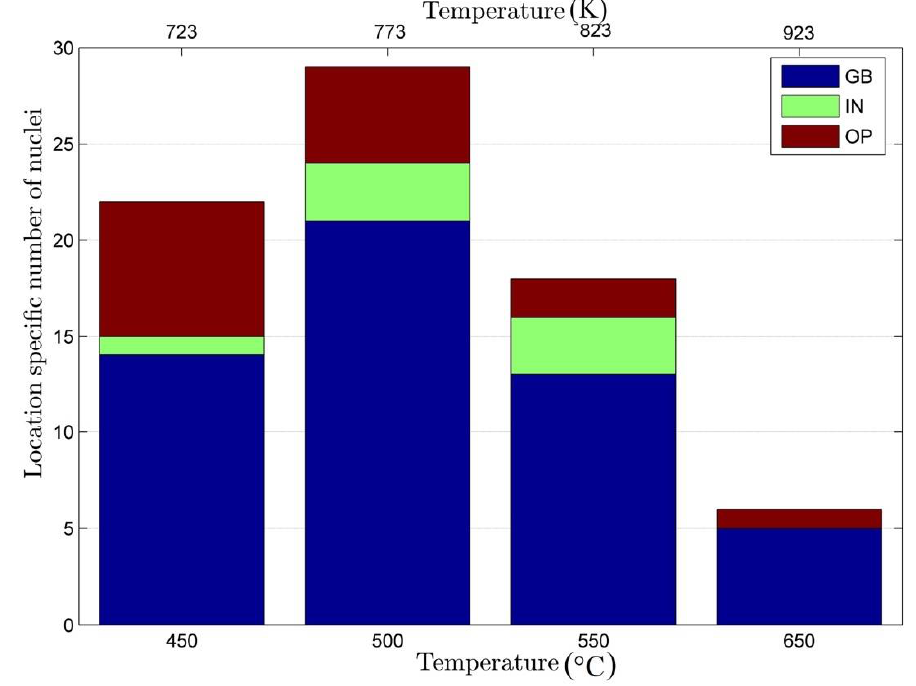
Figure 12. Total number of observed nucleation events grouped by the observed nucleation sites versus the isothermal temperature of each experiment.